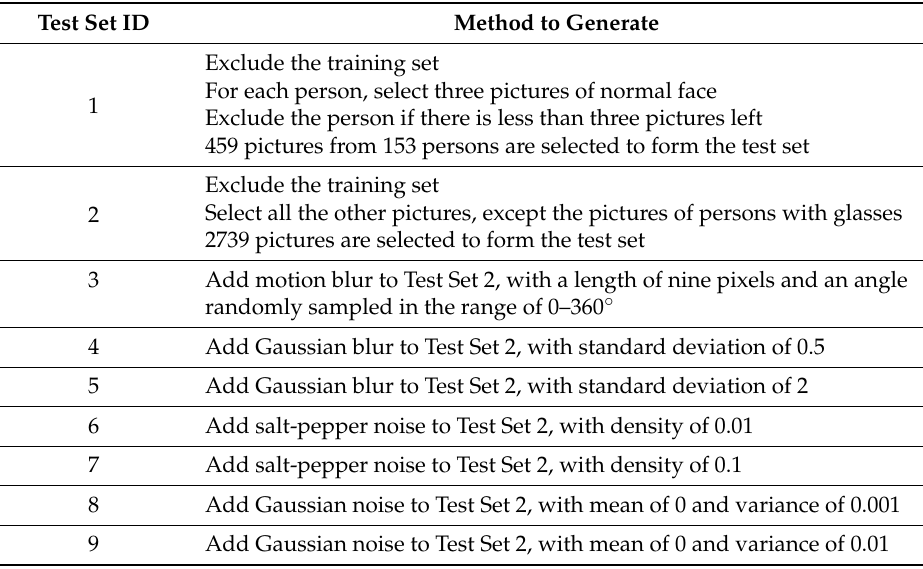
Table 2. Methods to generate testing datasets.